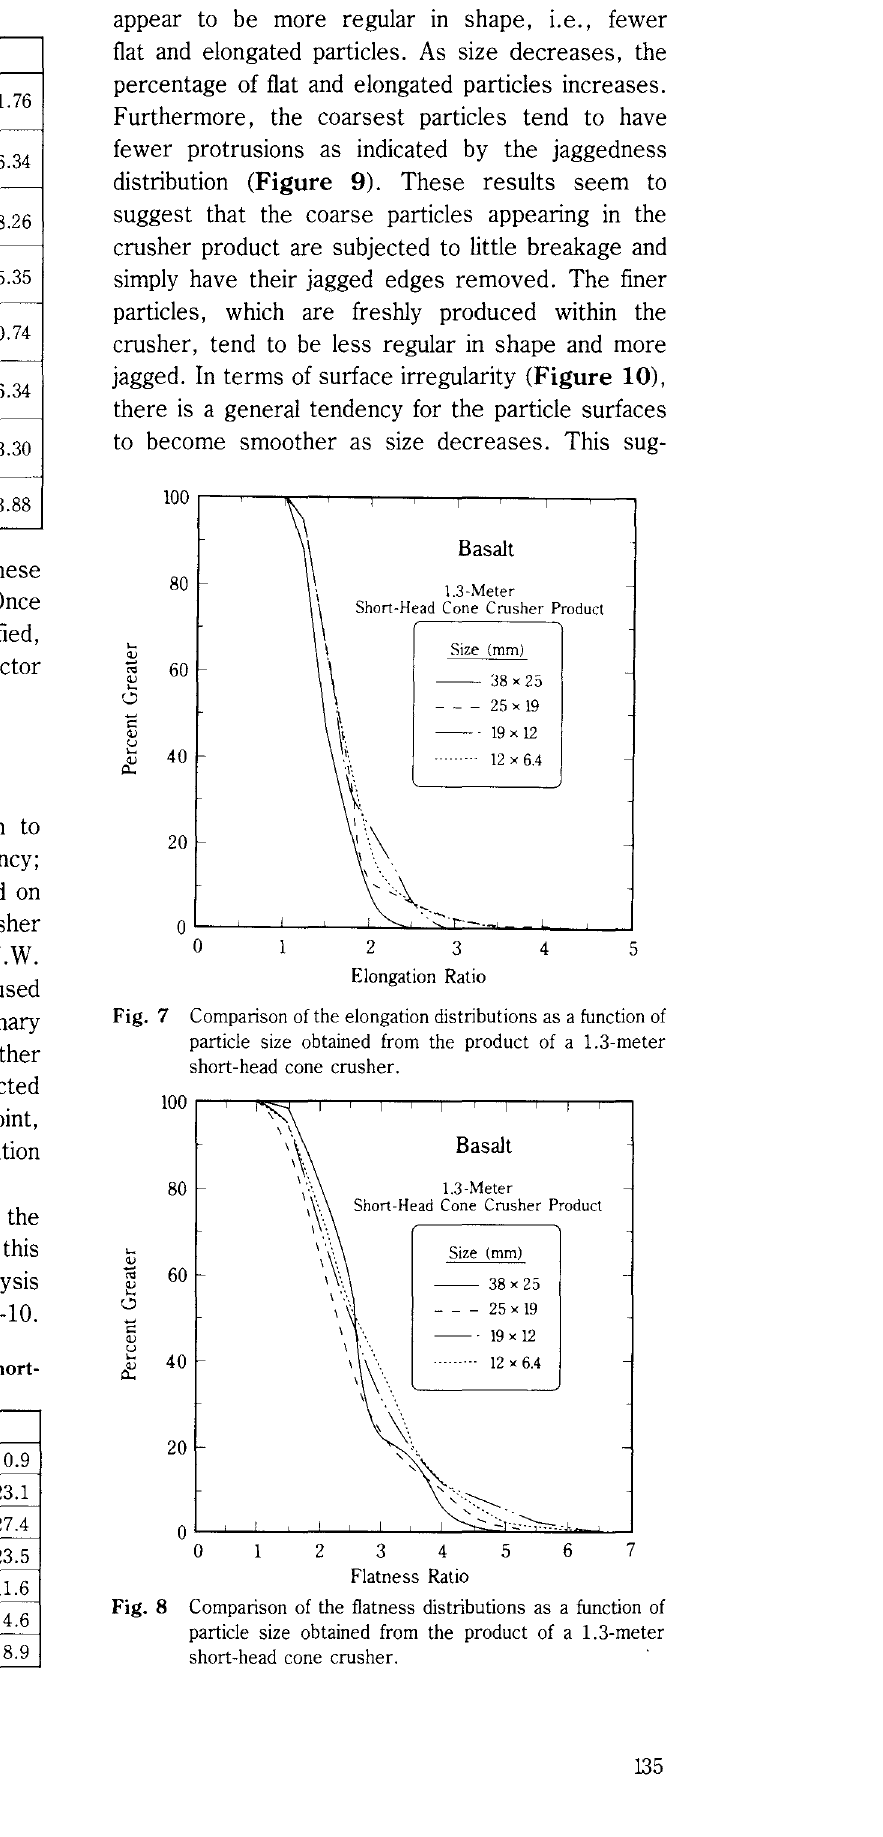
Table 1. Roughness measurements made on several standard shapes.